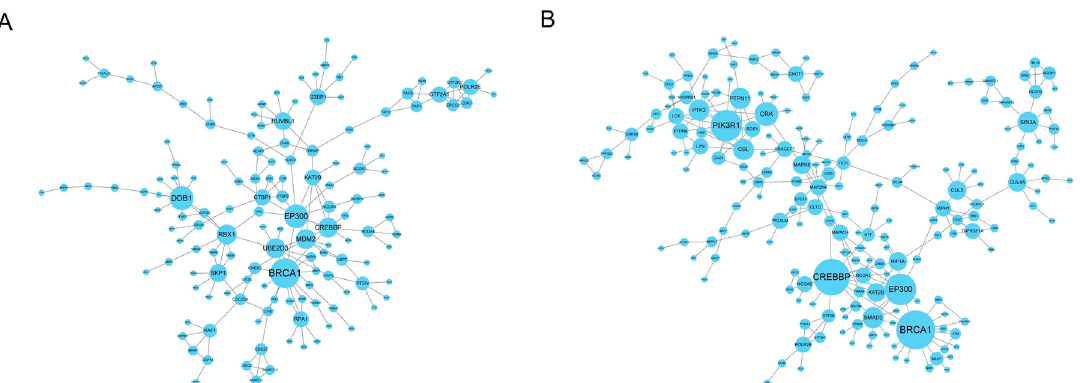
Figure 4. PPI network analysis of host genes. ( A ) The host genes of up-regulated circRNAs from the protein–protein interaction network. ( B ) The host genes of down-regulated circRNAs from the protein–protein interaction network.